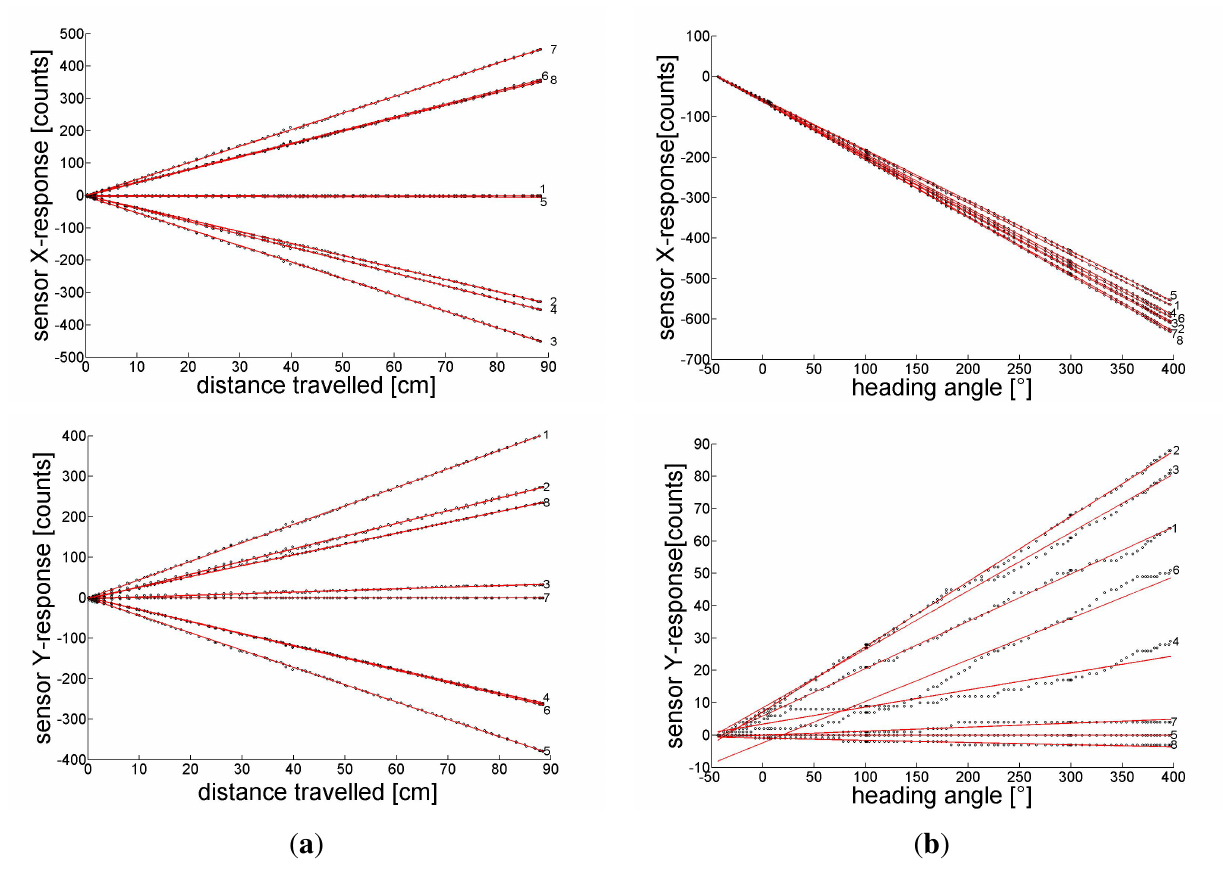
Figure 5. The accumulated X- (upper) and Y-response (lower row of sub figures) of the eight sensors to pure translation (column a) and pure yaw (column b) versus the traveled distance ( a ) and the orientation of the carriage ( b ) monitored by the tracking camera. Every fifth sensor response is marked by a black dot, red lines are a linear fit to them. The slopes of the linear fits in column (a) represent the ( X, Y ) ‘unit’ responses 1 cm of translation and those in column (b) to 1 ◦ of rotation of the responses see